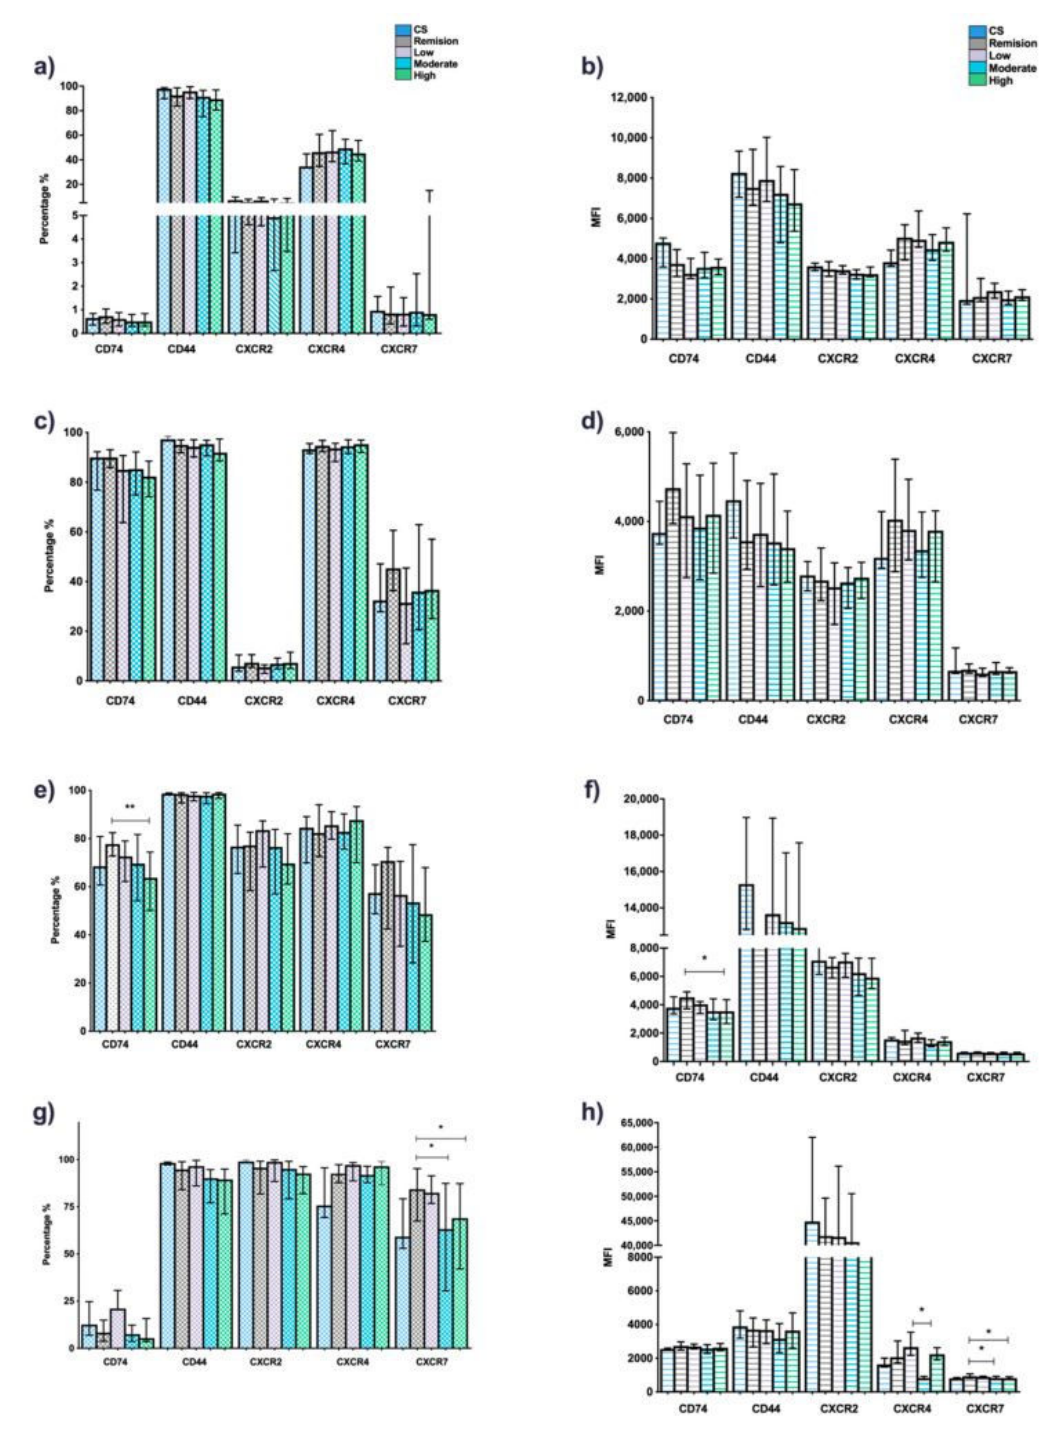
Figure 3. Expression of the canonical (CD74/CD44) and non-canonical (CXCR2, 4 and 7) MIF receptors in whole blood cells from RA patients stratified by DAS28-ESR. Percentage and MFI of cells positive for CD74, CD44, CXCR2, CXCR4 and CXCR7. T cells ( a ) and ( b ), B cells ( c ) and ( d ), monocytes ( e ) and ( f ) and granulocytes ( g ) and ( h ), of patients with RA ( n = 101) stratified by the DAS28-ESR: remission (<2.6, n = 27), low activity ( ≥ 2.6 < 3.2, n = 16), moderate activity ( ≥ 3.2 < 5.1, n = 35), high activity ( ≥ 5.1, n = 23). Data presented in median (p5–p95). Statistical comparisons between groups were determined using the Kruskall–Wallis test (DAS28). * p < 0.05; ** p < 0.01. RA: rheumatoid arthritis; CS: control subjects; DAS28, disease activity score 28; MFI: mean fluorescence